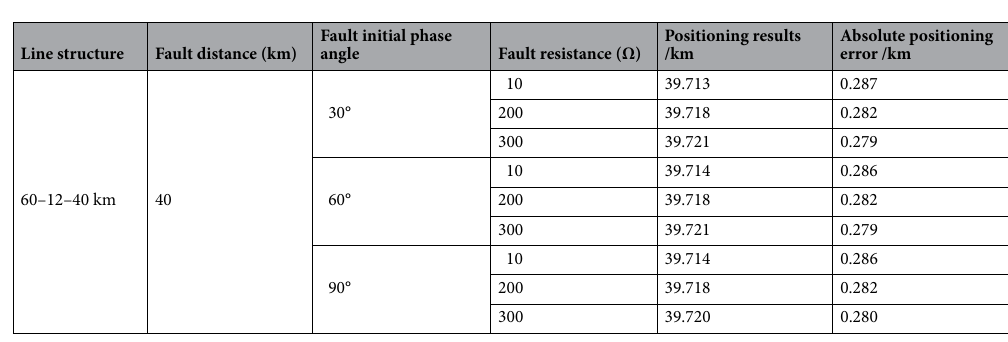
Table 7. Effect of initial phase angle of fault and transition resistance on positioning results.